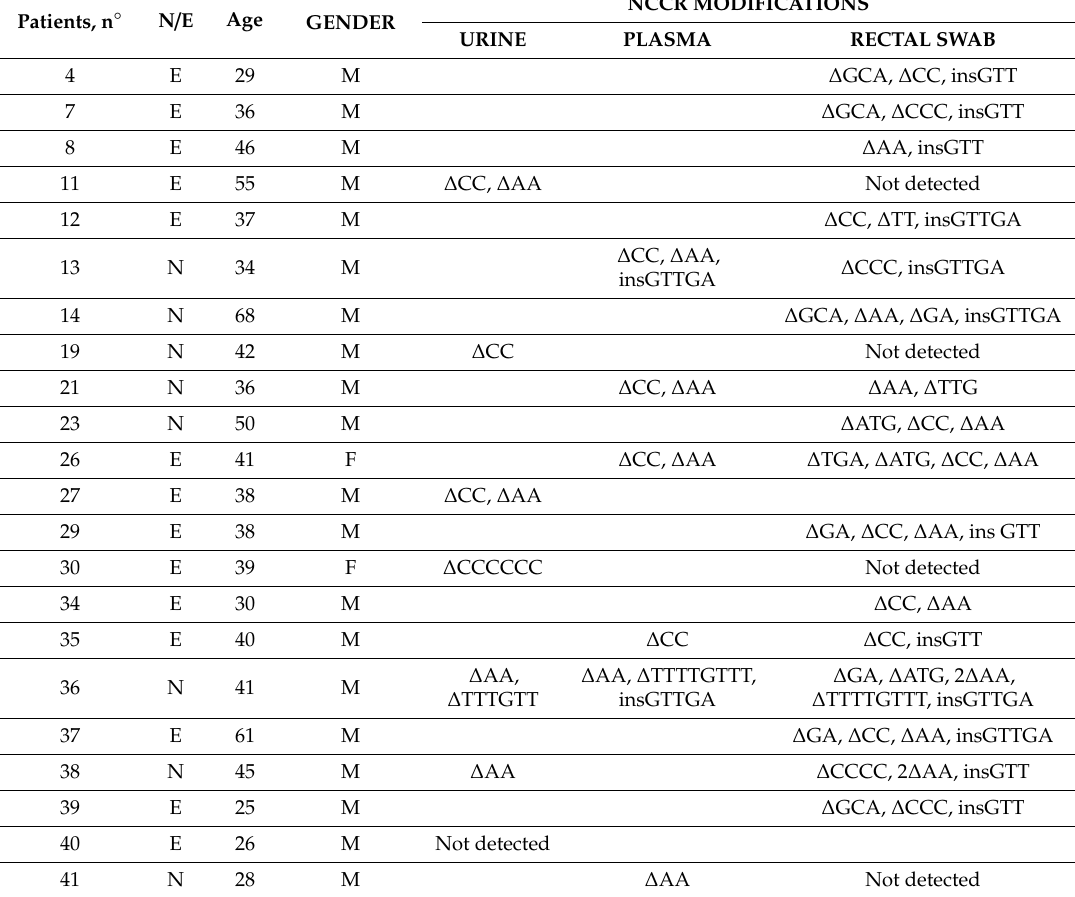
Table 3. Summary of the main NCCR modifications observed in MCPyV-positive patients relative to analyzed